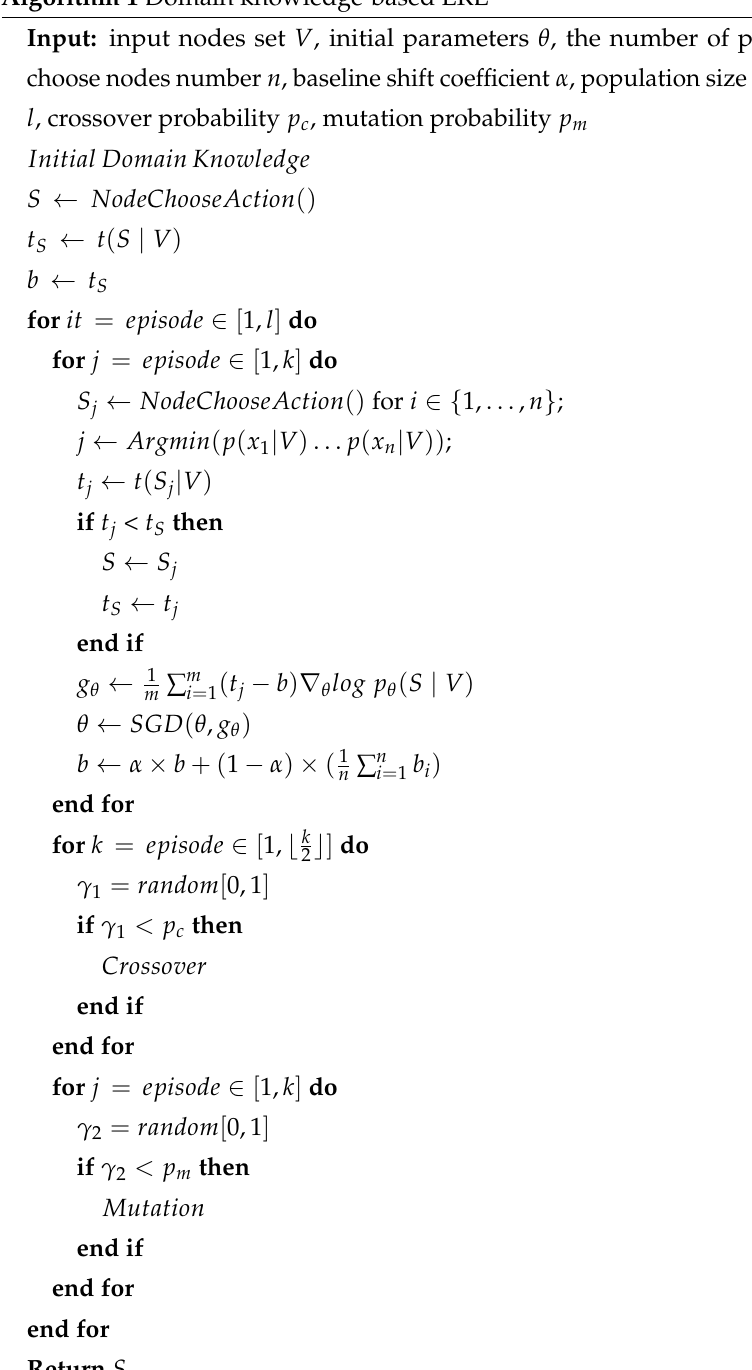
Algorithm 1 Domain knowledge-based